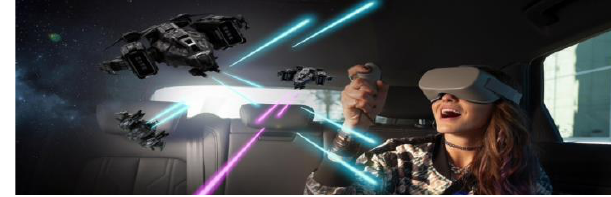
Fig. 4. VR Experience Form and Scene